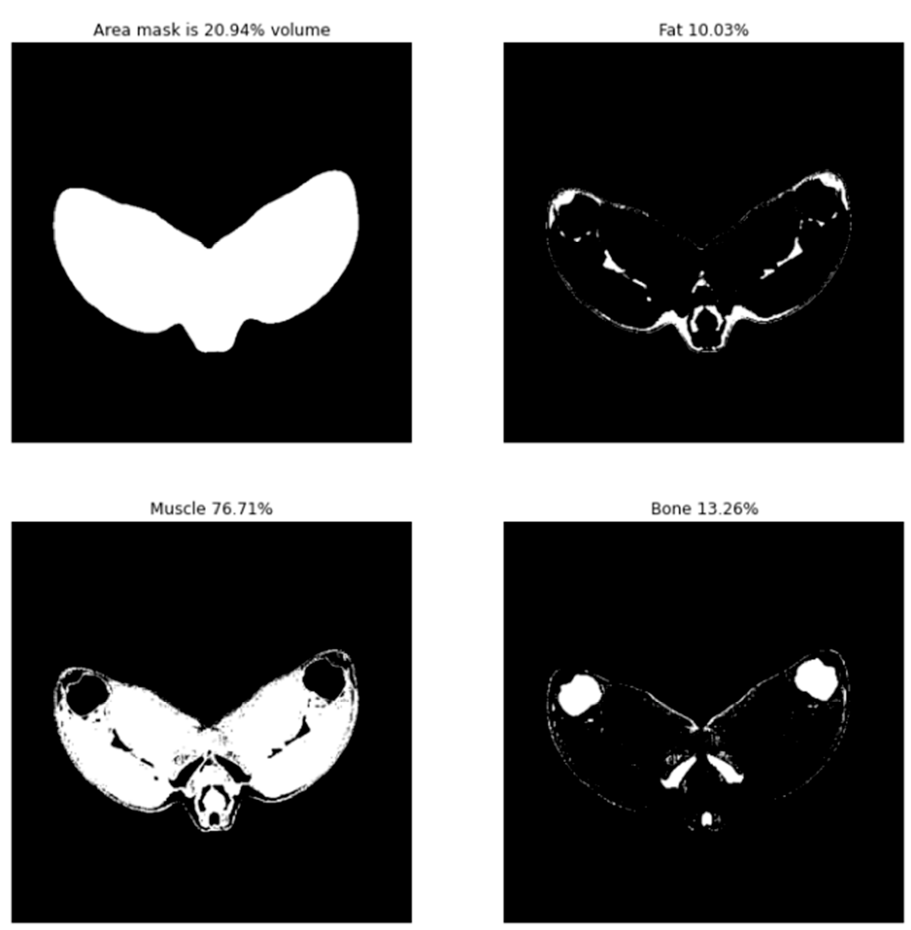
Figure 5. Representative tissue distribution of fat, muscle and bone within tissue area of predicted images. The results of the trained generative adversarial network were analysed by examining total area ( top left ) and by applying pixel intensity threshold windows to separately visualise fat ( top right ), muscle ( bottom left ) and bone ( bottom right ). The total number of pixels that fell within these pixel intensity windows determined the volume of the respective tissue types in the sample since 1 pixel = 1 mm 2 .